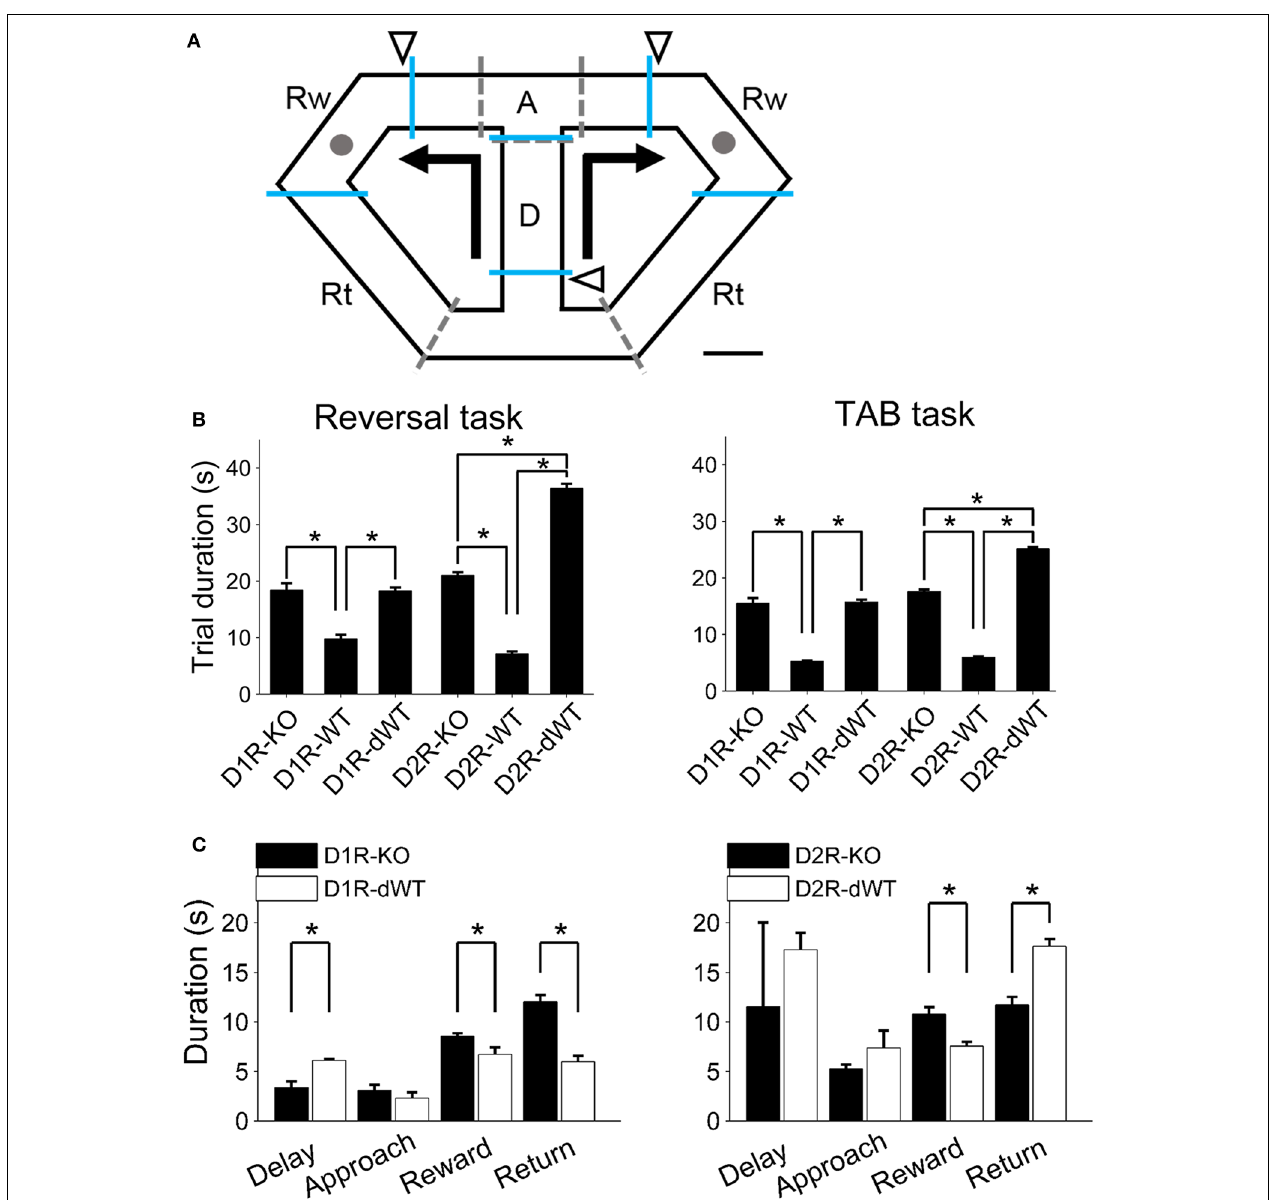
FIGURE 1 | Behavioral task and experimental groups. (A) Left, A schematic diagram of the modified T-maze used in the present study. Mice were allowed to choose between two target locations (gray circles) that delivered water reward. Arrows indicate movement directions that were controlled by opening and closing of 5 sliding doors (indicated by dashed lines). Triangles indicate locations of photobeam sensors. The maze was divided into four sections (blue lines; D, delay; A, approach to goal; Rw, reward; Rt, return to central stem). Scale bar, 6cm. (B) Mean trial durations ( ± s.e.m.) during the reversal and TAB tasks are shown for each experimental group. There were three experimental groups for each receptor subtype [KO, WT, and WT with delay (dWT)]. Delay was imposed to dWT animals on the